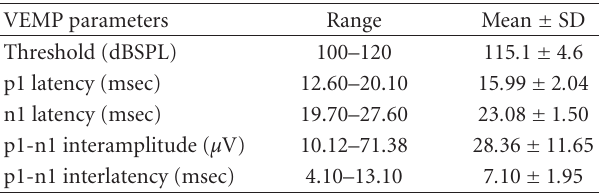
Table 1: VEMP parameters in 86 ears.